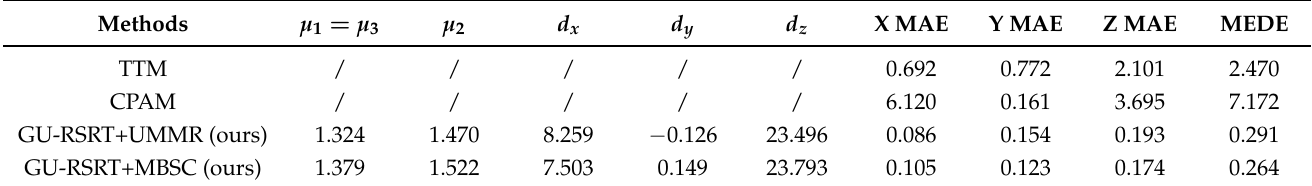
Table 6. The calibration results and 3D reconstruction errors of GelStereo Palm1.0 sensor. The unit of